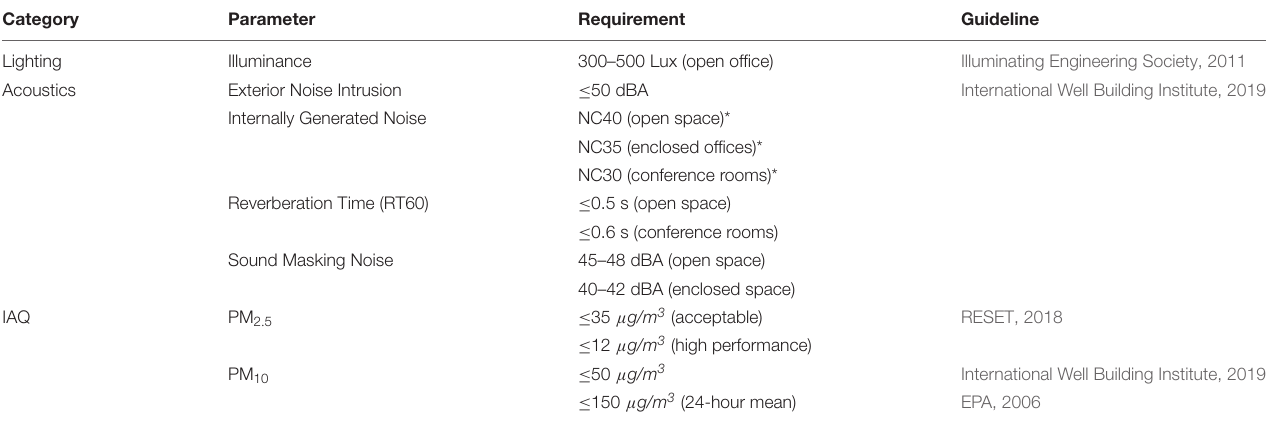
TABLE 1 | Requirements for environmental parameters of office space in various